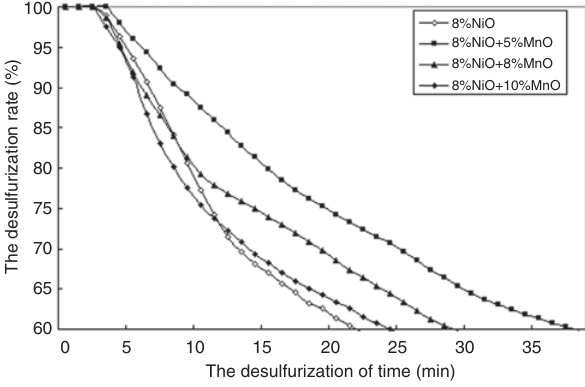
loading on the catalyst desulfuri- 2